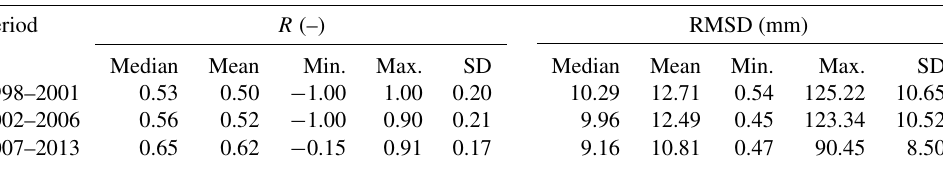
Table 3. Statistical summary of correlation coefficient ( R ) and root mean square difference (RMSD) for SM2RAIN-CCI against GPCC-FDD during the three calibration periods 1998–2001, 2002–2006 and 2007–2013. For each score, the median, mean, minimum, maximum and standard deviation values are reported.